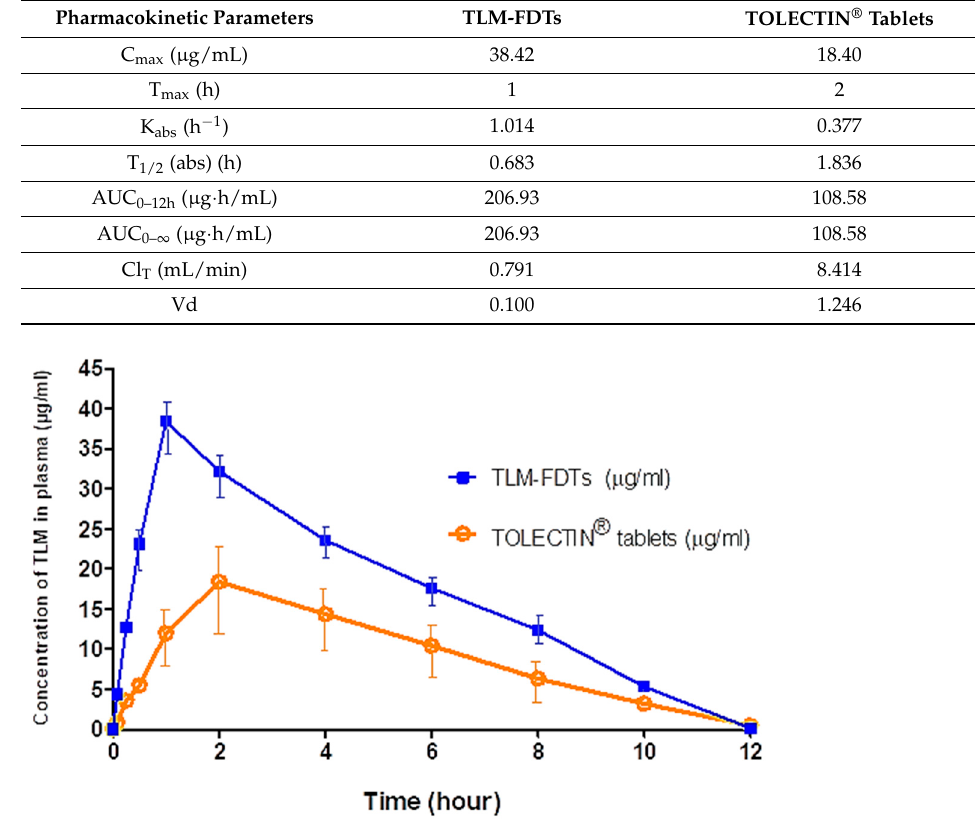
Figure 11. The mean concentration ‐ time curve of TLM ( μ g/mL) in plasma after oral administration of TOLECTIN ® tablets and TLM ‐ FDTs in rats. Data are presented as the mean ± SD ( n = 3). Table 6. The plasma pharmacokinetic characteristics of TLM ‐ FDTs and Tolectin ® tablets in rats after oral delivery.